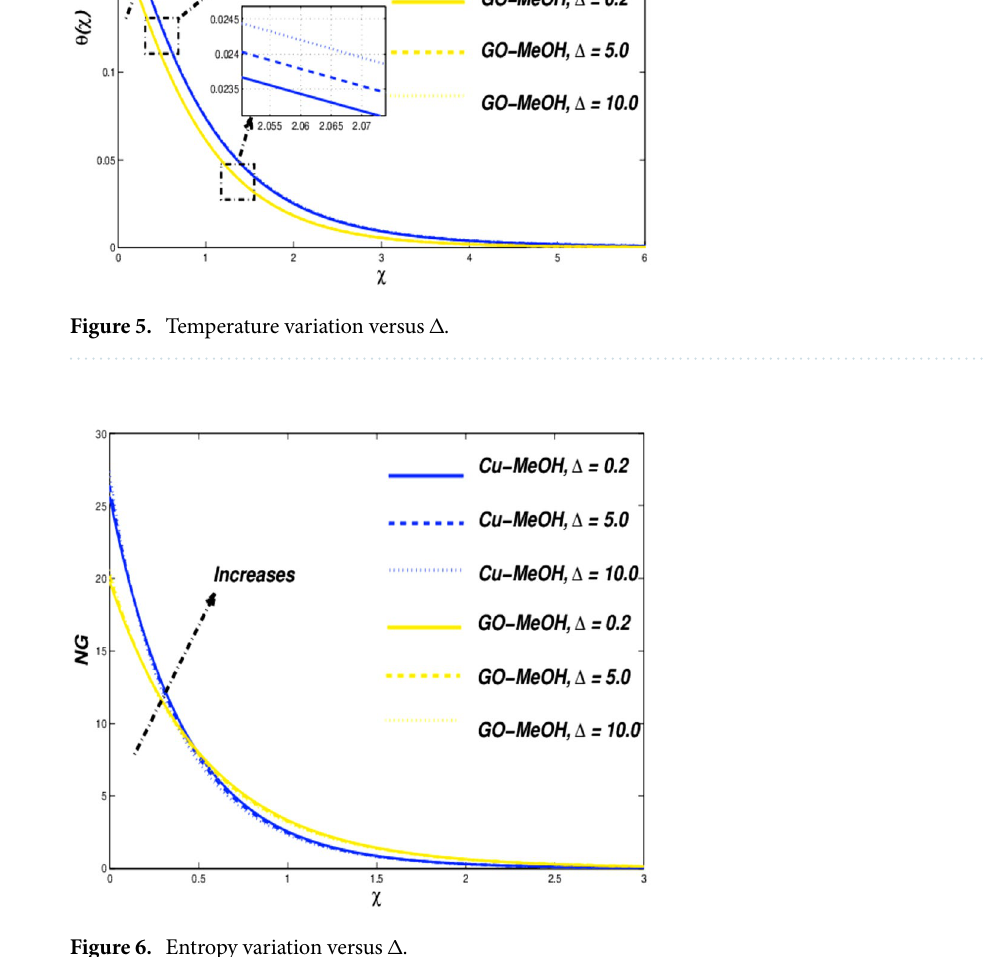
Figure 6. Entropy variation versus (cid:31)